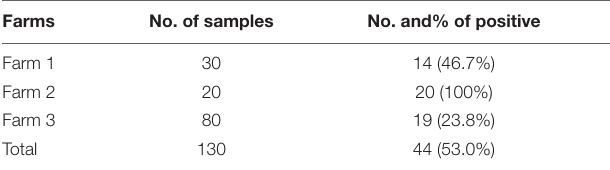
TABLE 2 | Detection rate of ORFV from the saliva of dairy goats. Farms No. of samples No. and% of positive